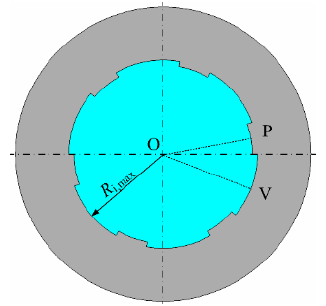
Figure 8. Radius diagram of the rib top and groove.